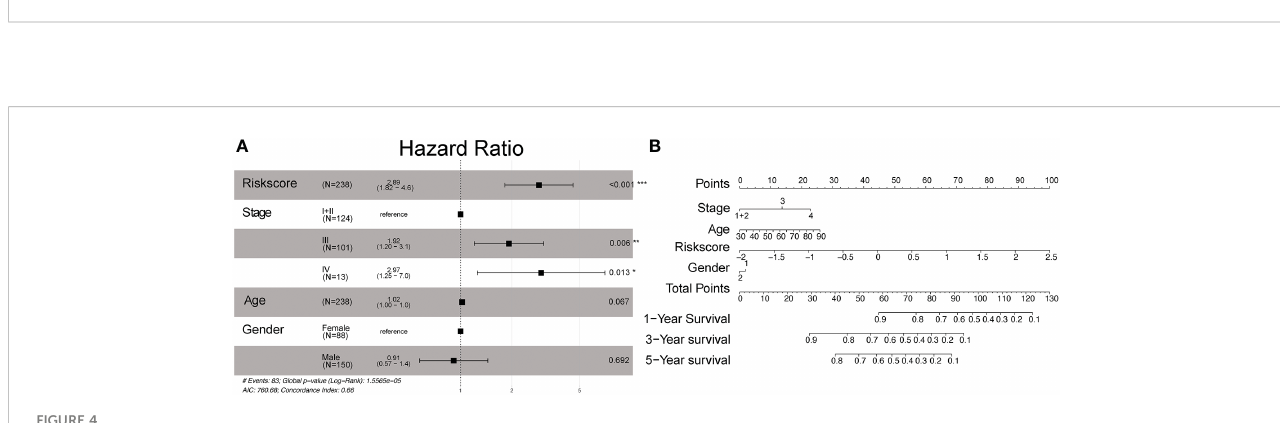
FIGURE 3 Prognostic OS analysis of the four-gene signature model in the validation cohort in GSE62254. (A – E) Kaplan – Meier curves for the OS of patients in the high-risk group and low-risk group in the TNM stage (total, I, II, I+II). (E, F) Kaplan – Meier curves for the OS of patients in the high-risk group and low-risk group for age (age<60, age ≥ 60) in the training cohort. (G, H) Kaplan – Meier curves for the OS of patients in the high-risk group and low-risk group for gender (female, male) in the training cohort.